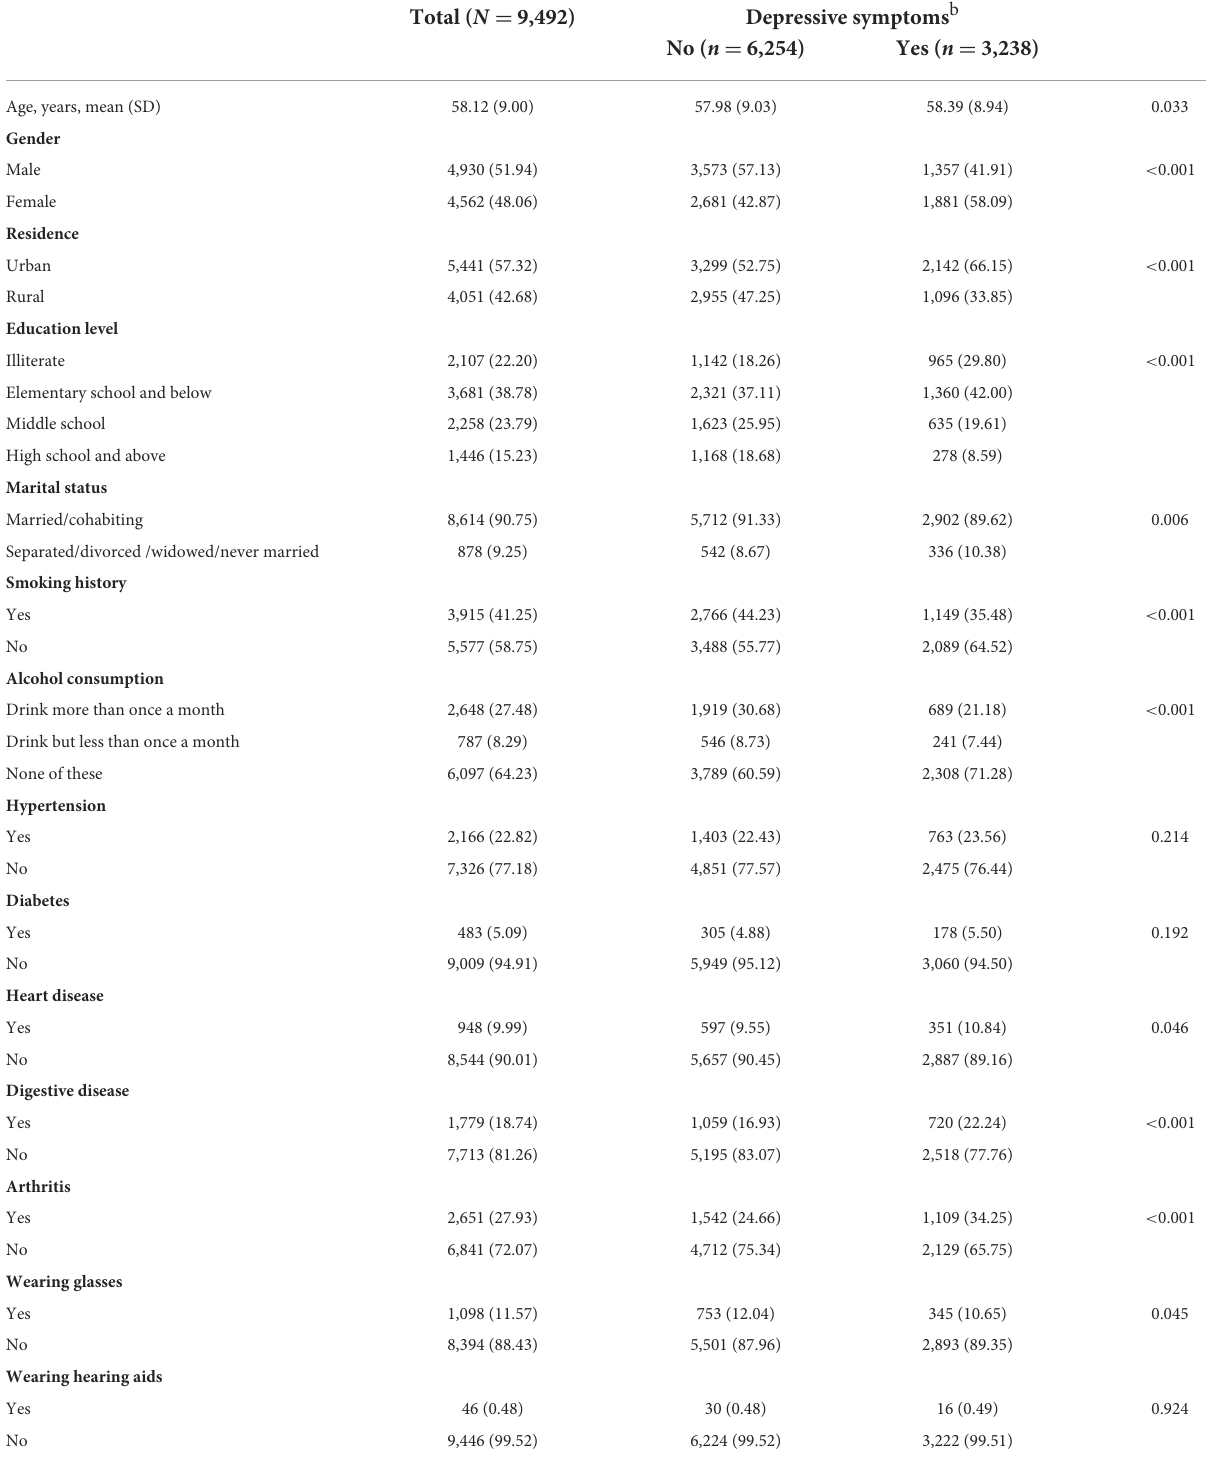
TABLE 1 The characteristics of the selected participants at CHARLS 2011 baseline.